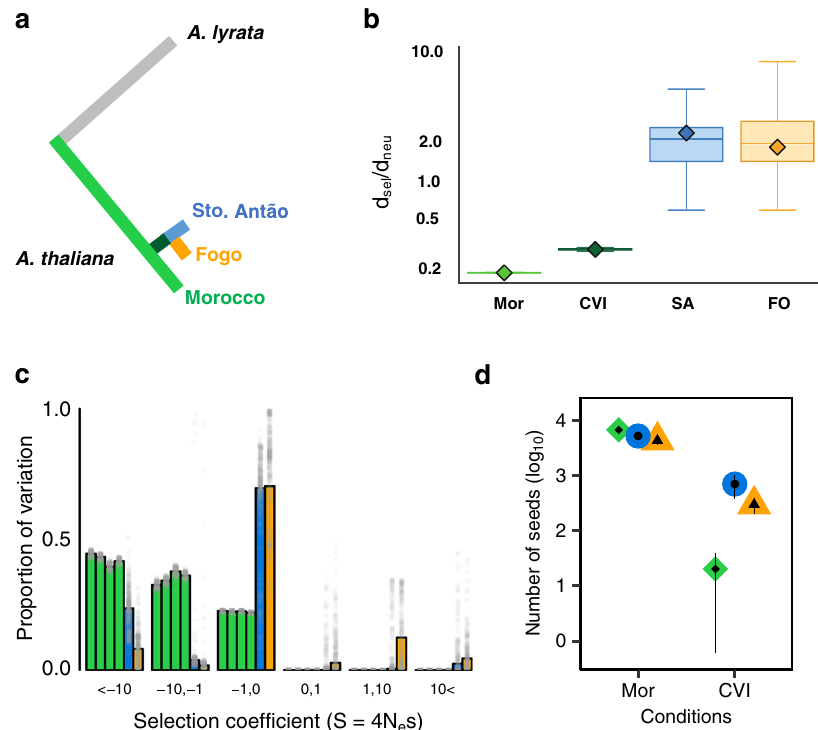
Fig. 5 Population genetic signatures of adaptive evolution in CVI. a Schematic of phylogeny separating branches examined in d sel / d neu analysis. b Evolutionary rate ratios d sel / d neu across populations (observed data shown as diamonds) with n = 500 bootstrap resampling replicates showing median (line), 1st and 3rd quartiles (bounds of box), minimum and maximum (whiskers). Mor: Morocco; CVI: branch between Morocco and CVI; SA: branch from the island split to Santo Antão; FO: branch from the island split to Fogo. c Distribution of fi tness effects for Morocco (green), Santo Antão (blue), and Fogo (orange). Grey dots represent estimates from 500 bootstrap analyses. d Fitness scaled to seed number in CVI and Moroccan lines under CVI and Moroccan conditions. Medians per population are shown by the dots, and 95% CI by the whiskers. Y -axis values are log 10 transformed. Source data are provided as a Source Data fi